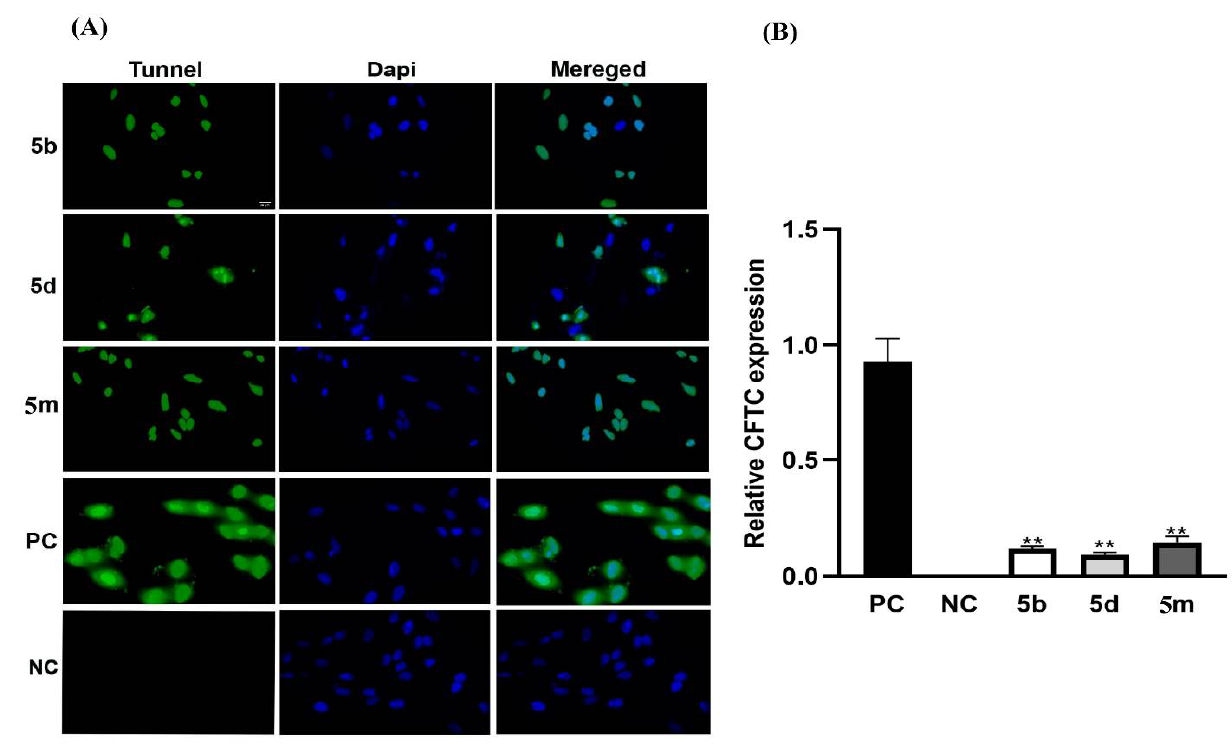
Figure 8. Colony formation assays were performed to determine the relative rate of proliferation of brain cancer LN229 cell line. ( A ) Representative images of the colony-forming assay. ( B ) Quantifi- cation of the colony formation rate for LN229 cells. Data are presented as the mean ± standard de- viation from three independent experiments. Ns- not significant * p < 0.05, *** p < 0.001, **** p < 0.0001 vs. respective control group.